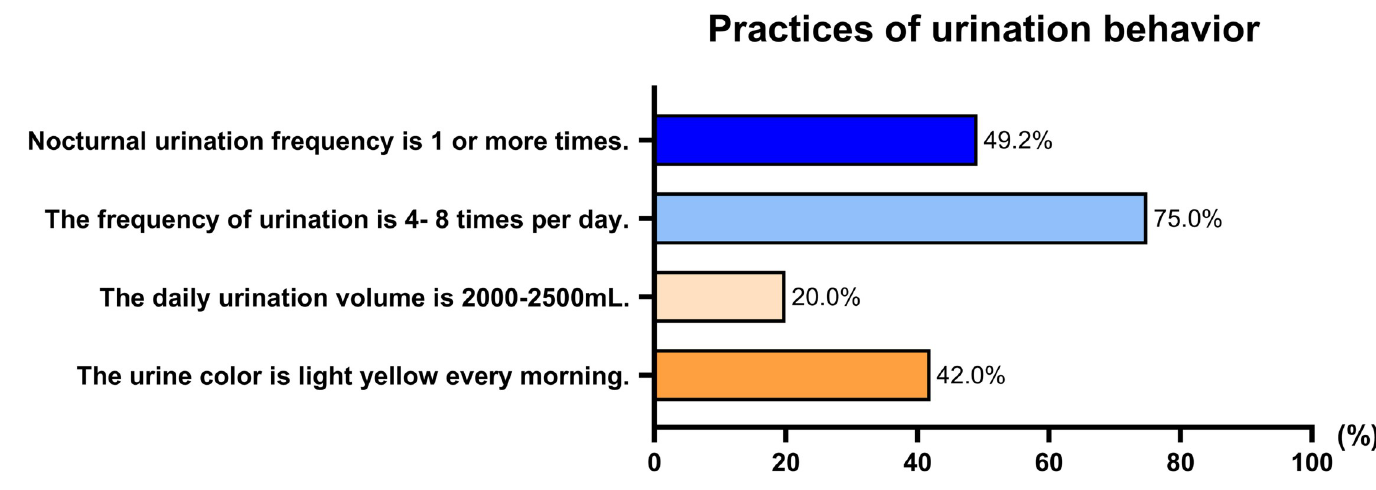
Fig 3. Practices of urination behavior.